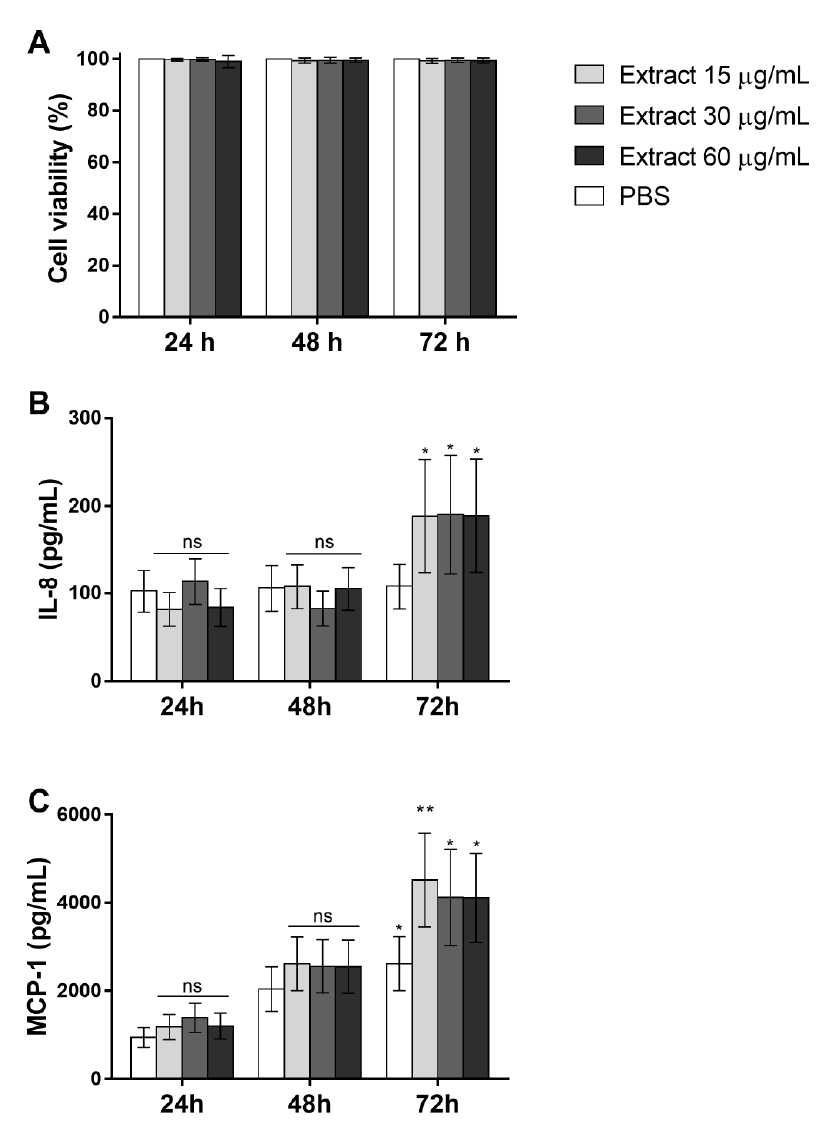
Figure 8. Cell viability and chemokine levels in cultures of EA.hy926 cells stimulated with Pararama hair extract. The endothelial cell line EA.hy926 (5 × 10 4 cells/well) was treated with 15, 30, or 60 µg/mL extract or PBS for 24, 48, and 72 h in a CO 2 incubator. After stimulation, the production of IL-8 and MCP-1 was determined in the supernatants of the cultures, and cell viability, expressed as a percentage, was evaluated by the MTT assay. The results are presented as the mean ± SD of three independent experiments. ( A ): Cell viability. ( B ): IL-8 levels. ( C ): MCP-1 levels. * p < 0.05; ** p < 0.01. ns: not significant.